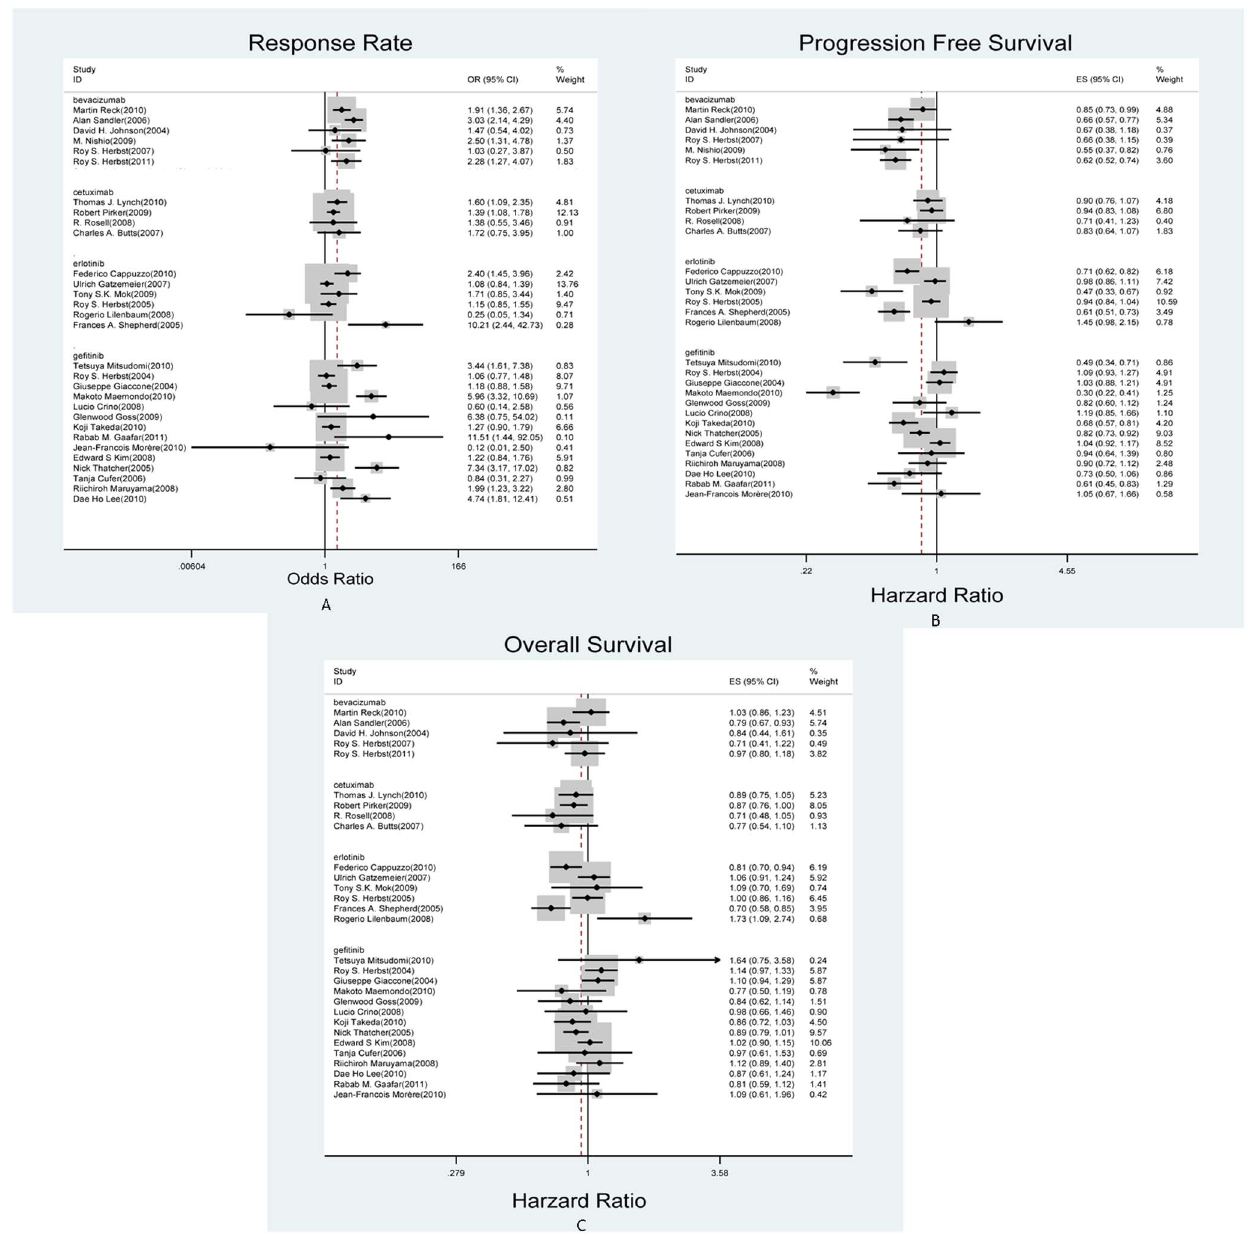
Figure 2. Forest plots of individual trials. A: Odds ratio of response rate; B: Hazard ratio of progression free survival; C: Hazard ratio of overall survival.